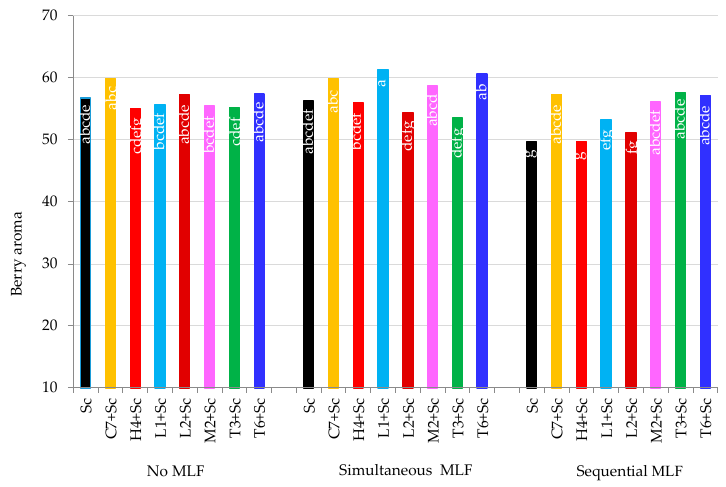
Figure 4. Percentage (%) berry aroma in Shiraz wines produced with Saccharomyces cerevisiae (Sc) on its own or in combination with Candida zemplinina C7, Hanseniaspora uvarum H4, Lachancea thermotolerans strains L1 and L2, Metschnikowia pulcherrima M2 and Torulaspora delbrueckii strains T3 and T6, and three malolactic fermentation (MLF) strategies (none, simultaneous and sequential). Mean values followed by the same letter did not differ significantly ( p ≤ 0.5).